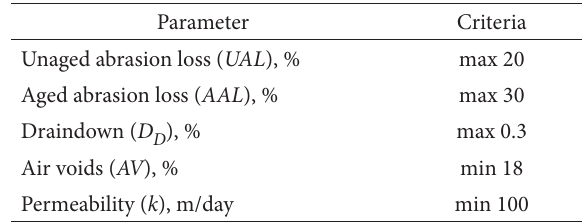
Table 6. Requirements for selection of OBC for OGFC ( ASTM D7064:2013 )